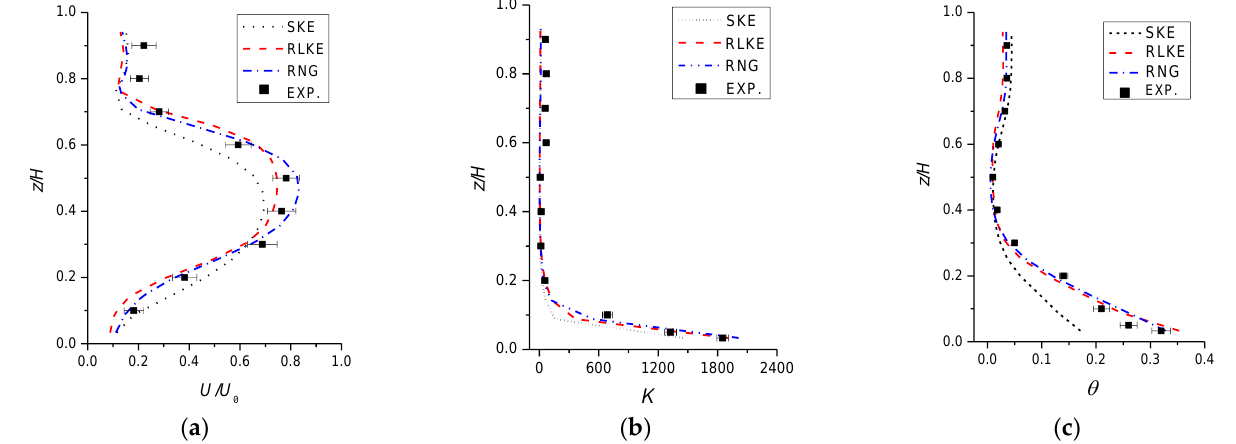
Figure 5. Model validation (standard, realizable, and RNG k - ε models vs. WT data) for cross-ventilation ( Ri = 0.27). ( a ) U/U 0 , ( b ) K and ( c ) θ along the indoor vertical center line.